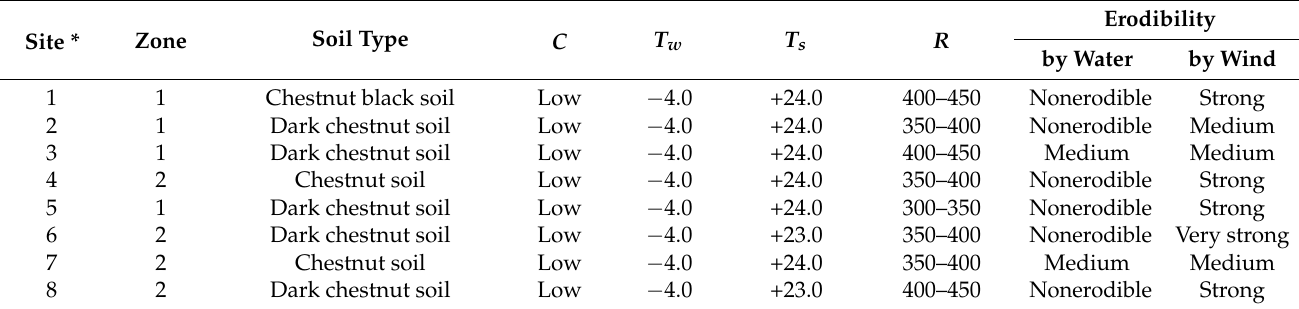
Table 6. Potential areas for relocation of winter wheat sites in Central